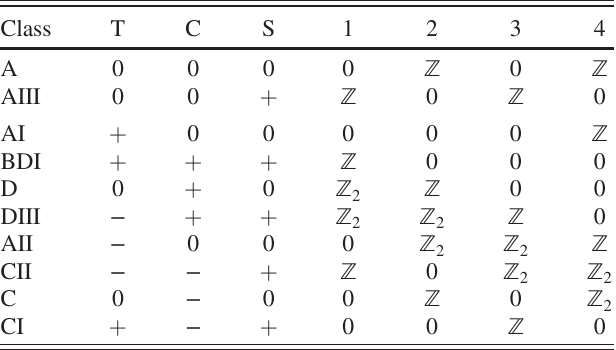
TABLE III. Periodic table of topological insulators. The first two rows contain the classes without anti-untiary symmetries, for brevity we use the labels (cid:3) ≡ (cid:3) 1